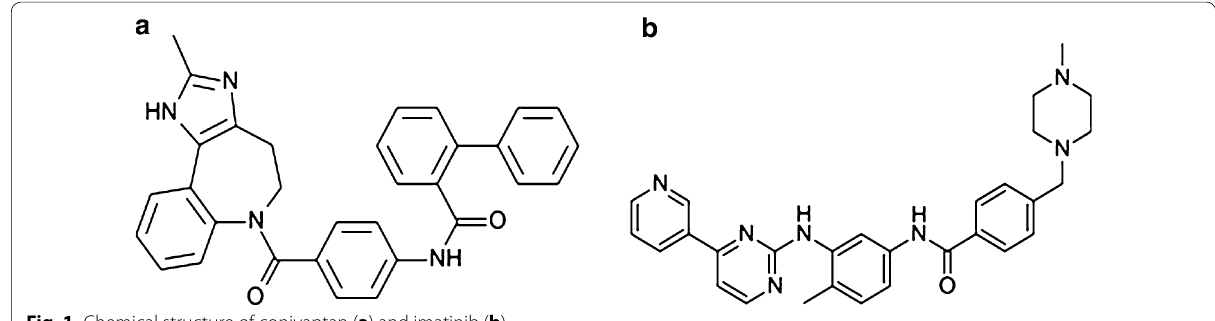
Fig. 1 Chemical structure of conivaptan ( a ) and imatinib ( b